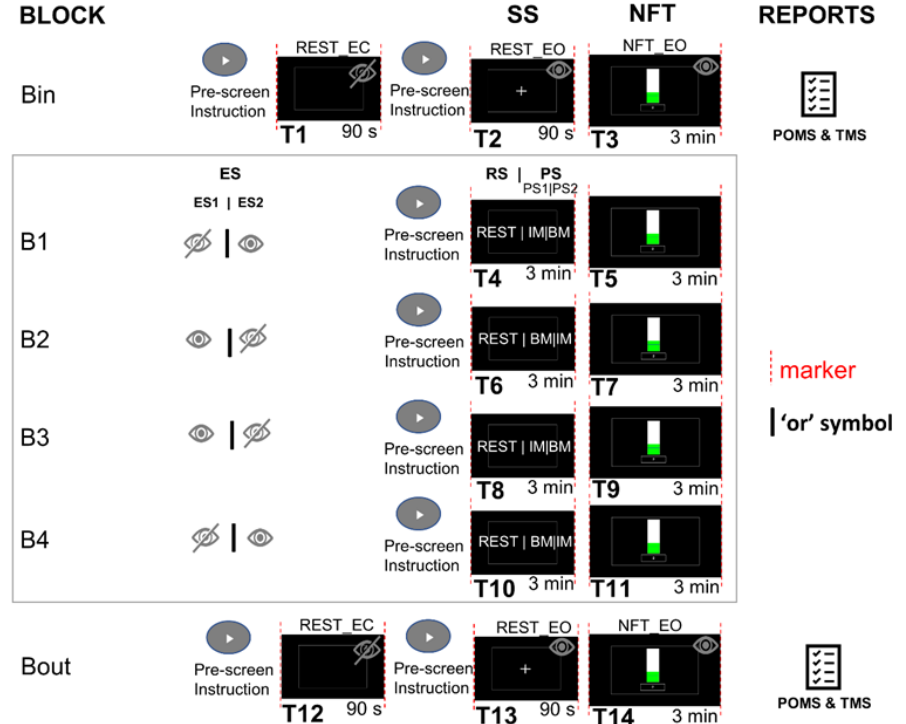
Figure 2. Experiment Block Mockup. Time flows from left to right, top to bottom. In a single session, first, the subject fills the traits self-reports. Then, the training starts. There are 6 blocks and 14 tasks in total. Block in and Block out each begins with rest state with eyes closed then eyes open, followed by alpha NFT. From block 1 to 4, in the EG first is the PRIME, then NFT. In the control group PRIME is substituted by REST. PRIME stimuli are randomized between IM and BM with two PS, PS1 and PS2. Moreover, from blocks 1 to 4, eyes closed and eyes open are randomized between blocks with two ES, ES1, and ES2. In the diagram, the “ or ” signal is represented by “ | ” . It is used to separate the task for each group or the randomizations of ES (EO|EC) between blocks and the randomizations of PS (BM|IM).